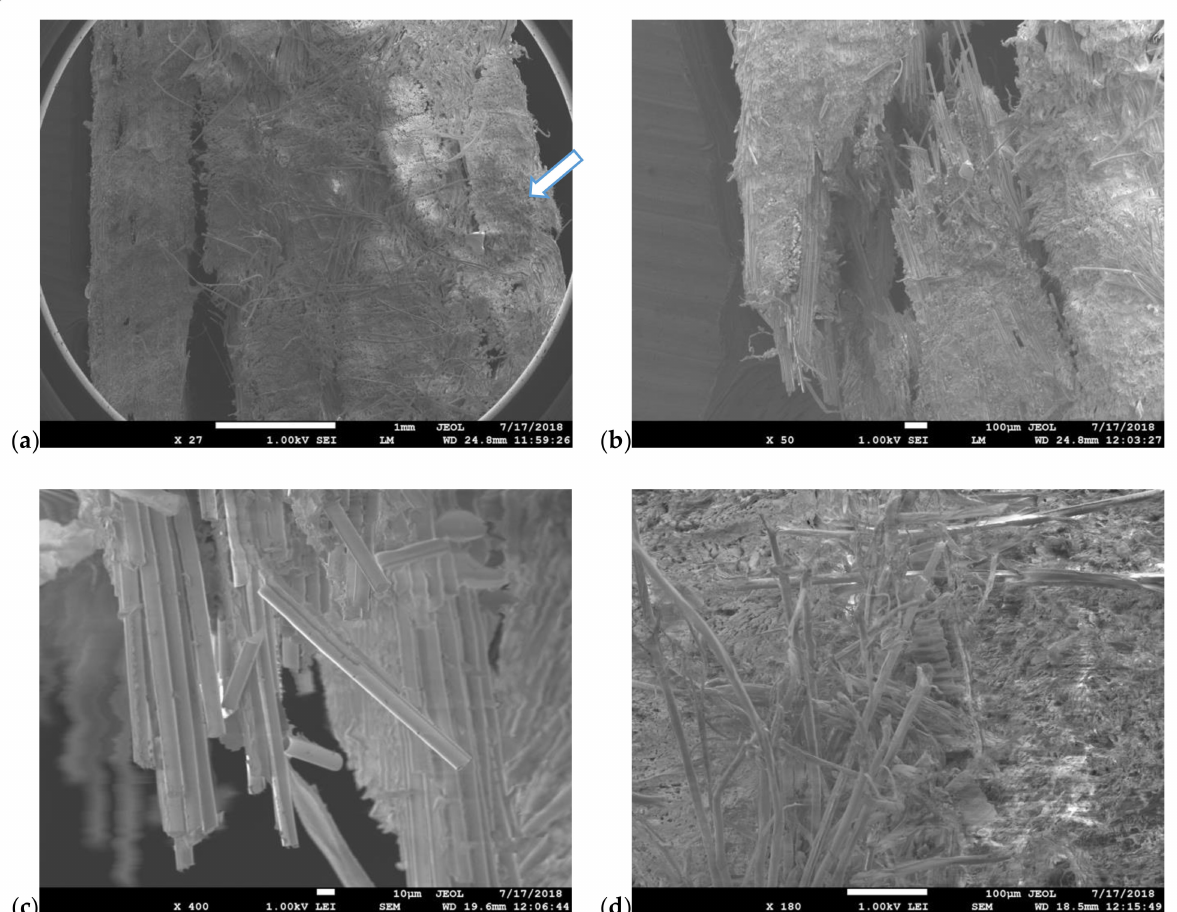
Figure 15. Scanning electron microscopy from the fracture area of the Kevlar/aluminum–glass composite hybrid three-point bending specimens (tensile side). ( a ) Tensile (left) and compressive side (arrow shows) delaminations, ( b ) delamination and ply cracking on the tensile side, ( c ) multiple glass fiber fragmentations, ( d ) brooming of Kevlar